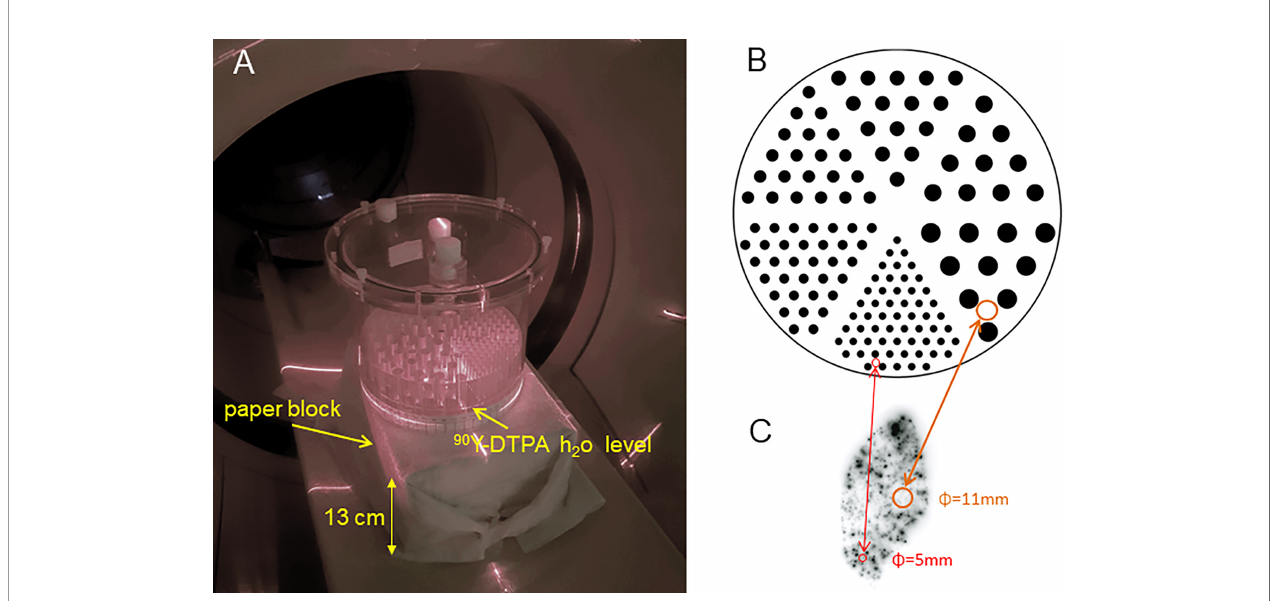
FIGURE 1 | (A) Jaszczak deluxe phantom set in a vertical position on a paper bloc modelling the patient attenuation. Only a part of the hot rod insert was fi lled with an active solution to reach a typical clinical tumour absorbed dose using a 3GBq total 90 Y activity. (B) Actual hot rods map. (C) Autoradiography of a normal liver (NL) tissue resected 9 days post 90 Y resin spheres liver radioembolization delivering 52Gy to the NL tissue [reprinted from (35) with permission of EJNMMI]. (B, C) are represented at the same